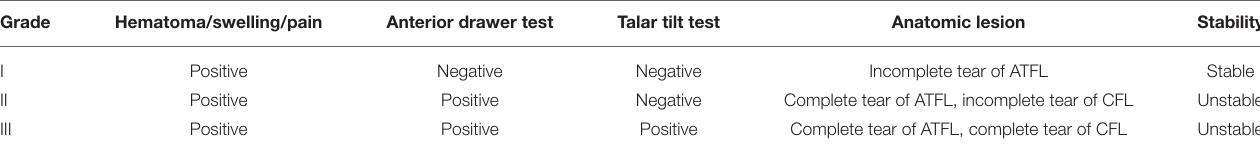
TABLE 1 | Classification of lateral ankle sprain based on increasing ligamentous damage and morbidity.